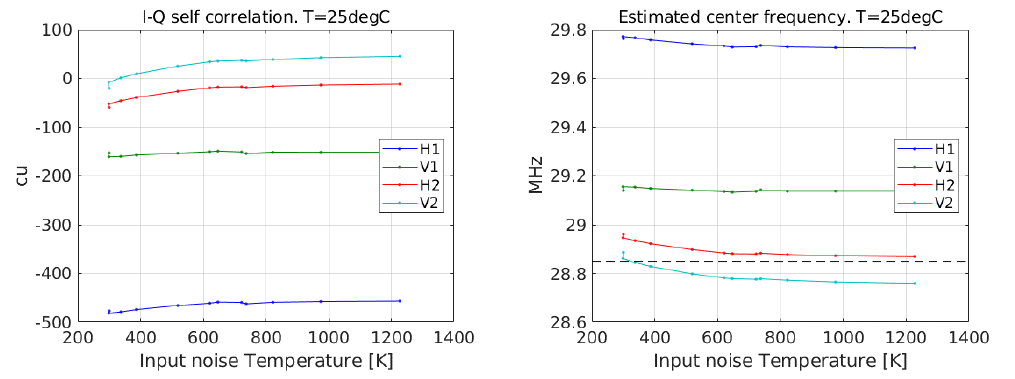
Figure 8. Self-IQ correlation and estimated center frequency. The average errors with respect to the nominal value are 890.6, 294.0, 43.4, and − 58.6 kHz for receivers H1, V1, H2, and V2, respectively.